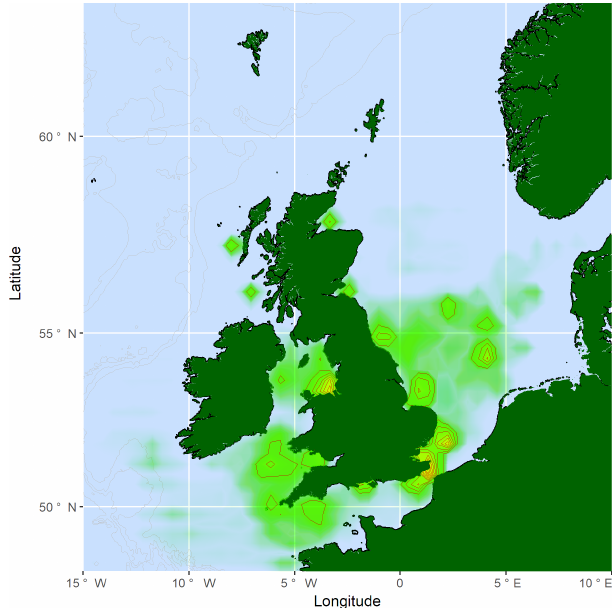
Figure 4. Overview of the relative data density in the English Chan- nel, the North, Irish, and Celtic seas, and the UK Continental Shelf area.